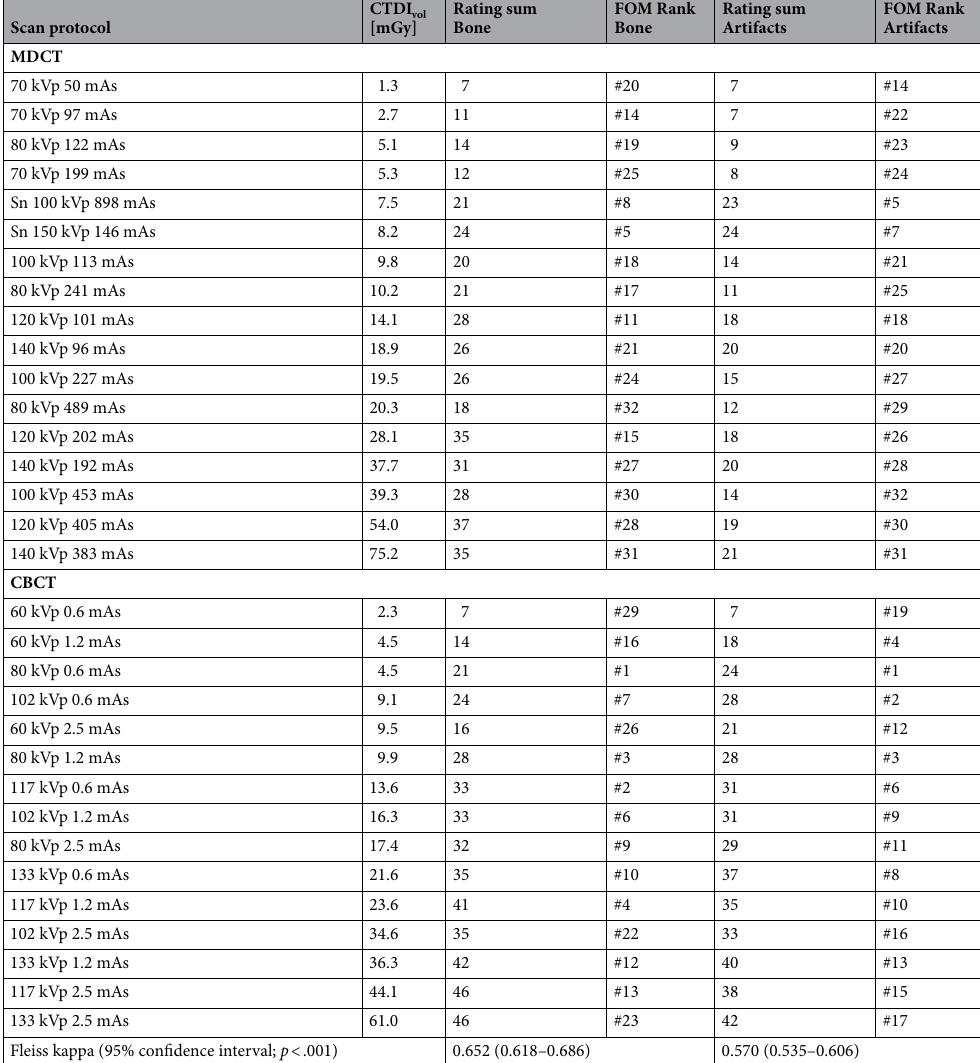
Table 3. Multi-observer assessment of bone image quality and artifact intensity. CBCT, cone-beam computed tomography; FOM, figure of merit (sum of ratings 2 /CTDI vol ); MDCT, multidetector computed tomography; Sn, 0.4 mm tin